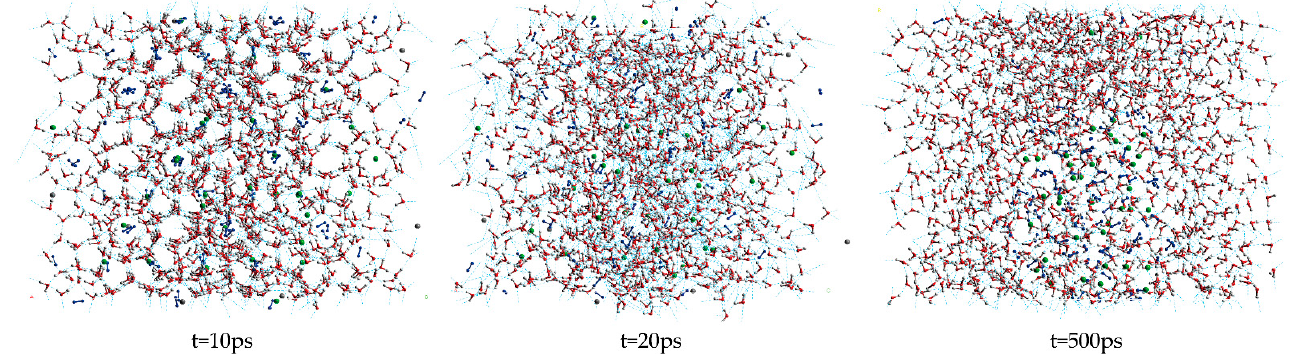
Figure 1. Snapshot structures of molecular dynamic runs to simulate A0 model structure after 500 ps at P = 2 MPa and T = 273 K.